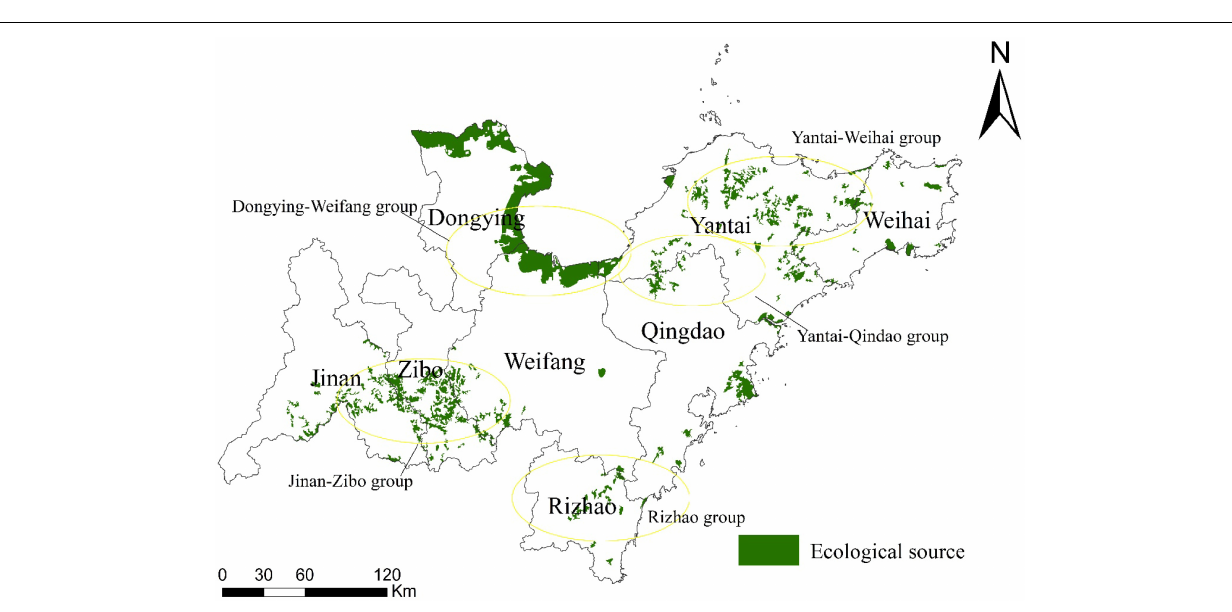
FIGURE 5 | Spatial distribution of ecological sources in Shandong Peninsula urban